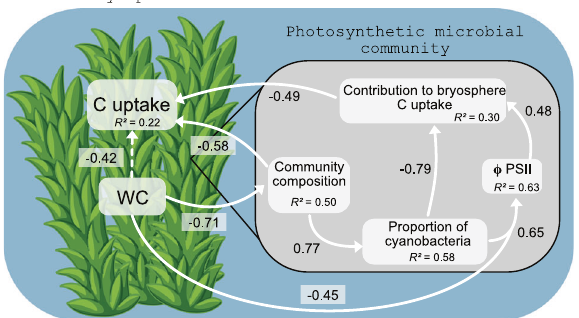
Fig. 5 Structural equation model re fl ecting the main drivers of the contribution of photosynthetic microbes to bryosphere C uptake. Only standardized path coef fi cients with P < 0.05 are shown. Ratio C/P: ratio between the abundance of cyanobacteria and total abundance of photosynthetic microbes. The amount of variance explained ( R 2 ) for each response variable are given in their respective box. The global fi t of the model was very good: AIC = 48.9, Fisher ’ s C = 6.86, P = 0.51. Dashed lines are nearly signi fi cant linkages (0.05 < P <